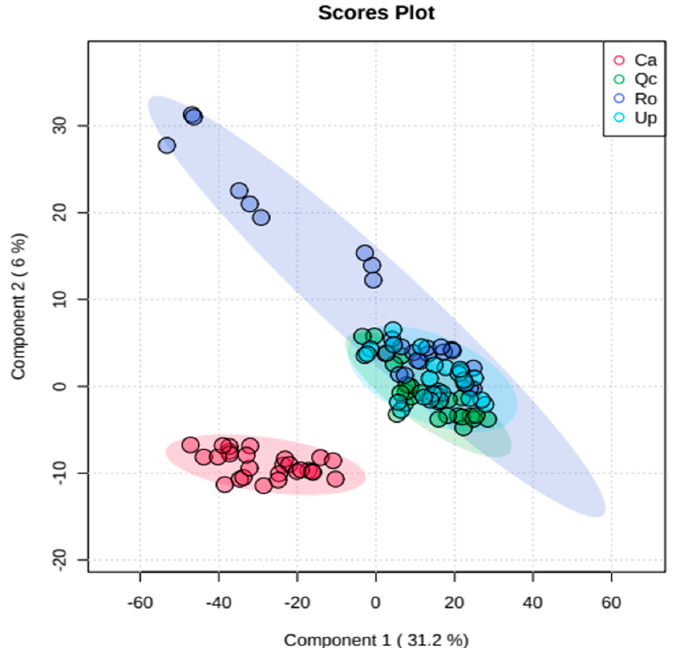
Figure 2. Partial least-squares discriminant analysis (PLSDA) of reflectance spectra of Ulex parviflorus (Up), Cistus albidus (Ca), Rosmarinus officinalis (Ro) and Quercus coccifera (Qc) in monospecific stands in control. n = 27. Measurements carried out between 27 April and 10 May 2022.